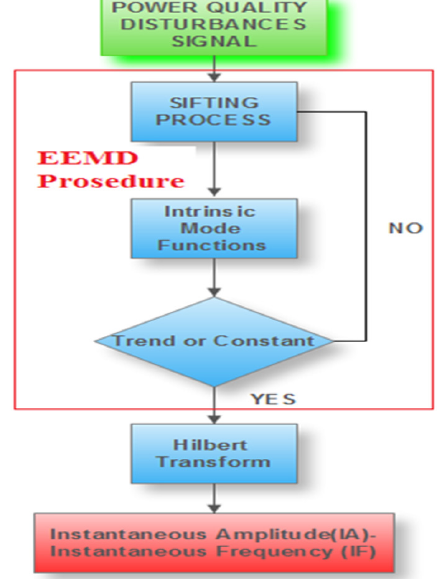
Fig. 3. Main steps of the feature generation routine with HHT